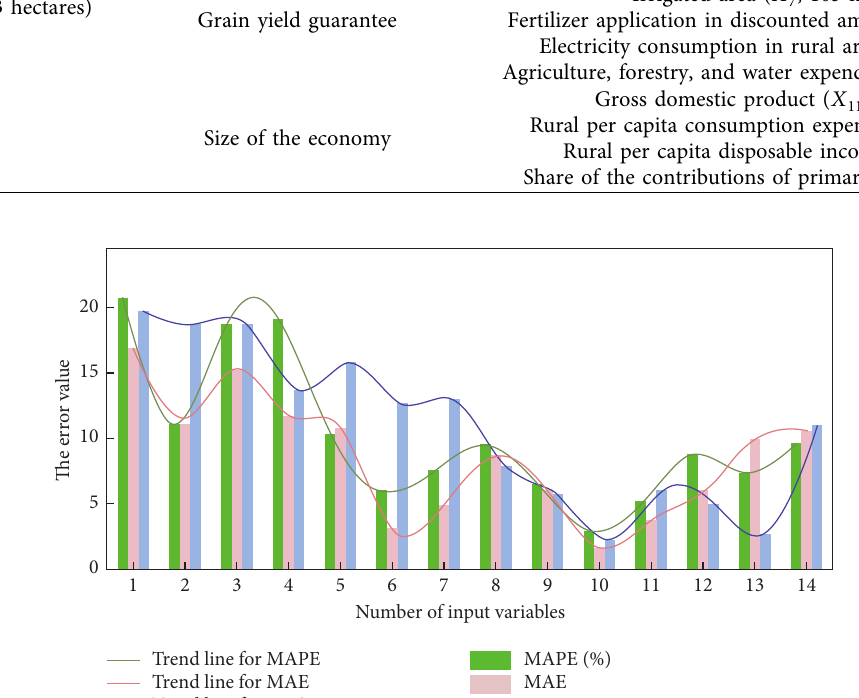
Figure 3: Comparison of model precision under different input variables.